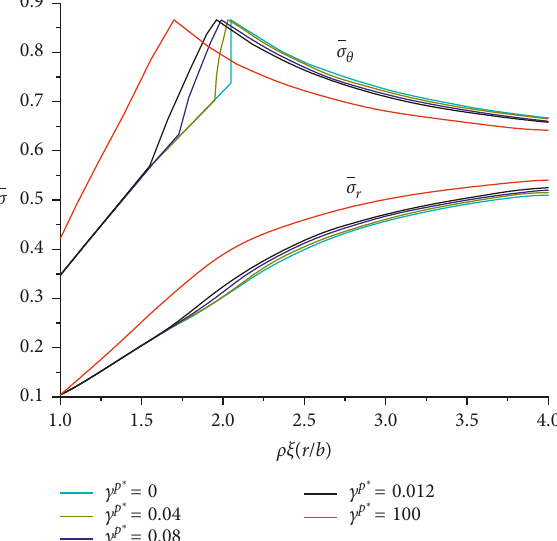
Figure 20: Comparison between dimensionless stresses with and without considering seepage force for Hoek–Brown rock mass.